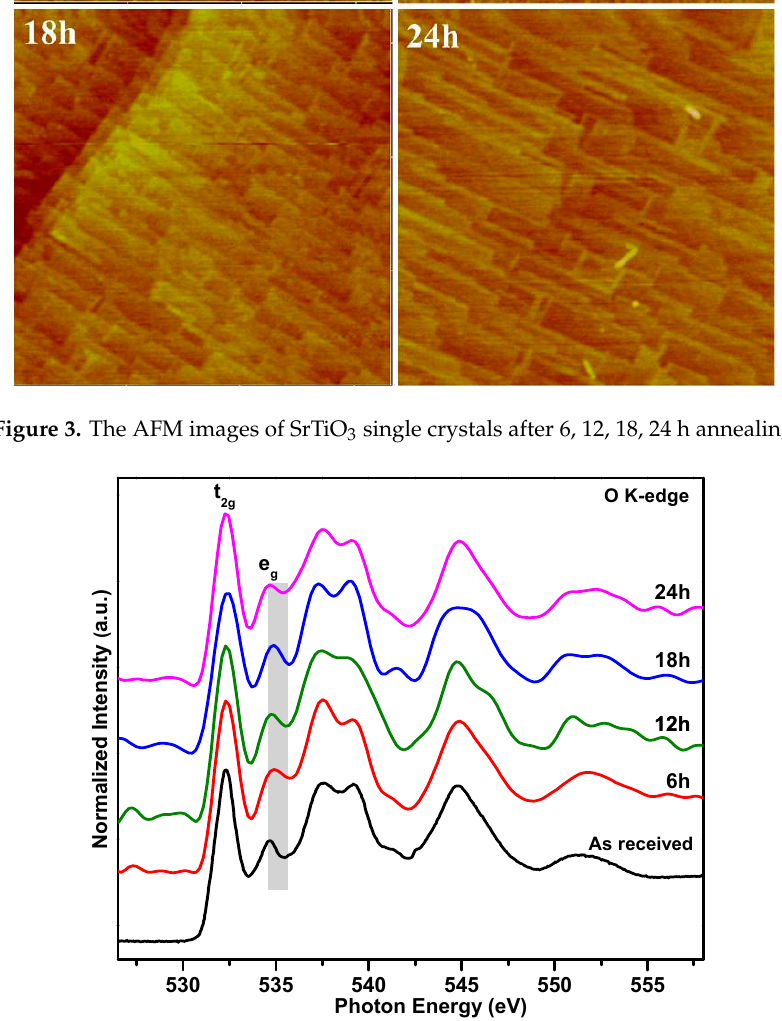
Figure 4. XAS spectra of O K-edge features of SrTiO 3 single crystals after 6, 12, 18, 24 h annealing.